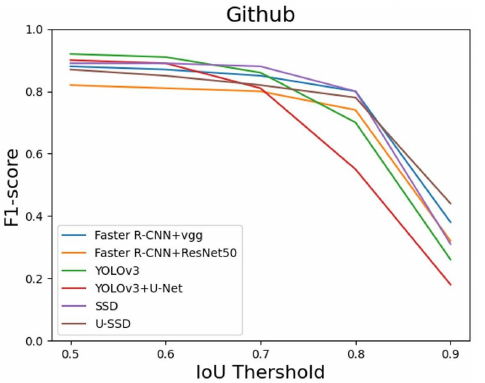
Figure 10. The F1-score from IoU = 0.5 to IoU = 0.9 on Github open dataset.